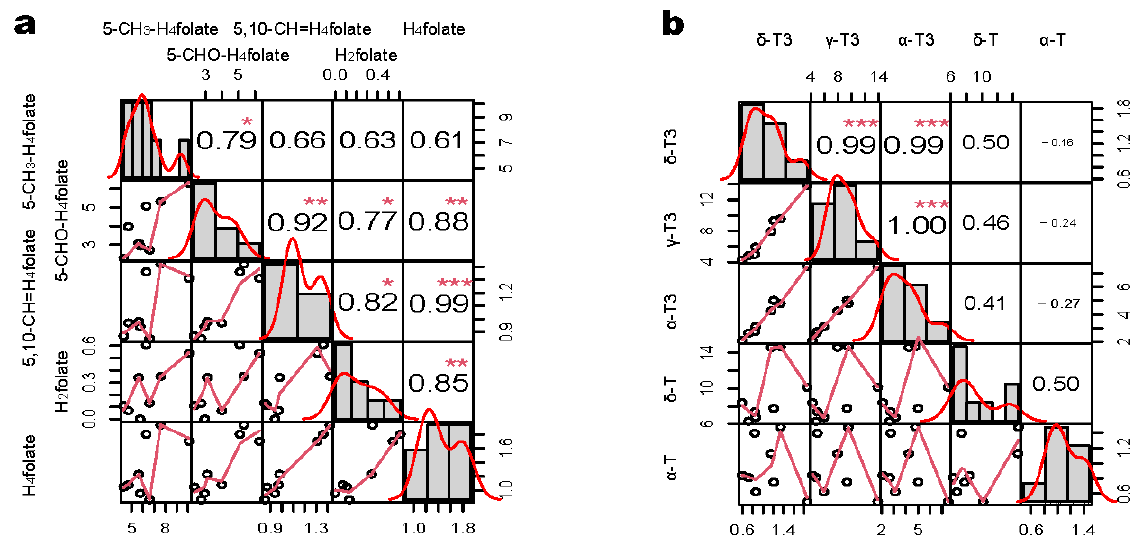
Figure 2. Correlation among the derivatives of vitB9 and vitE, respectively, in tubers of potato cultivars before steaming. ( a ) Correlation results among derivatives of vitB9; ( b ) Correlation results among derivatives of vitE. *, p < 0.01; **, p < 0.001; ***, p < 0.0001.